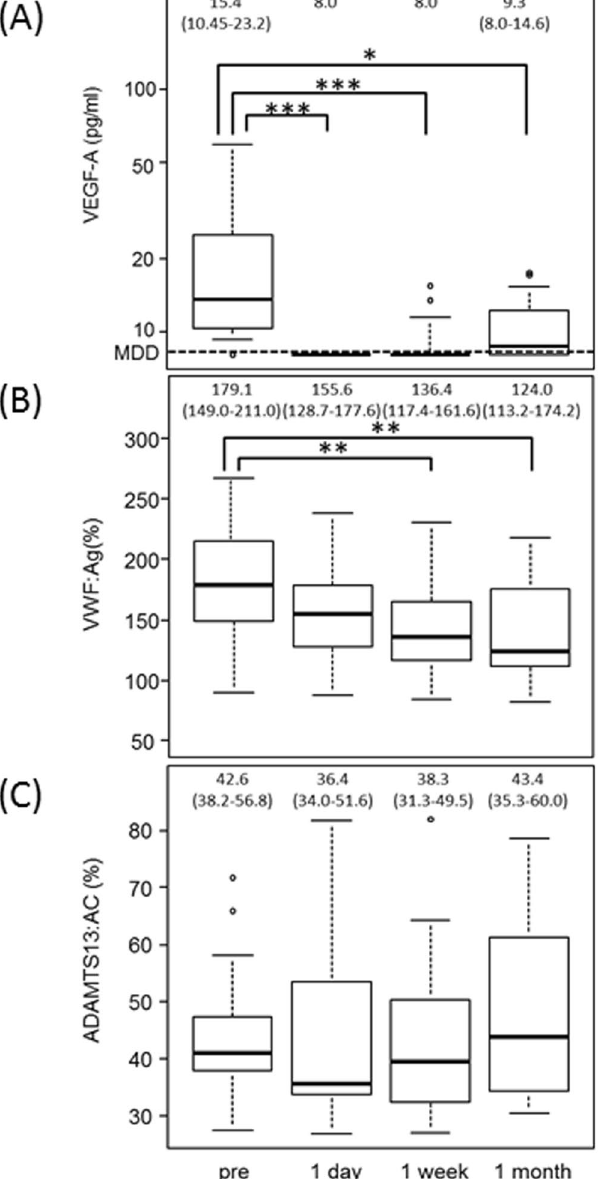
Figure 4. Plasma levels of VWF antigen, ADAMTS13 activity, and VEGF-A before and after intravitreal injection of aflibercept in patients with exudative AMD. ( A ) Plasma levels of VEGF-A were significantly decreased at 1 day after injection ( *** p < 0.001), and this reduction continued until 1 month after injection ( * p < 0.05). ( B ) Plasma VWF:Ag levels gradually decreased after injection, with a significant reduction starting at 1 week ( ** p < 0.01). ( C ) No significant change was observed in ADAMTS13:AC after